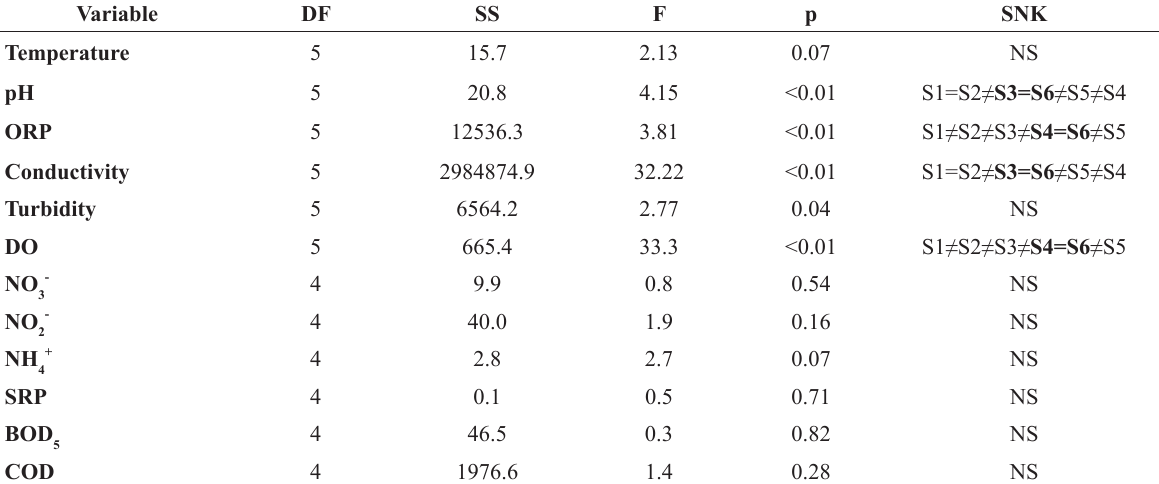
results of the analysis of Variance (anoVa) and a posteriori Student-neuman-Keuls (SnK) test for the physicochemical data recorded in Sites 1 to 6. orP: rEdoX potential; do: dissolved oxygen; no 3- : nitrates; no 2- : nitrites; nH 4+ : ammonia; SrP: Soluble reactive Phosphorous; dbo : biochemical oxygen demand; Cod: Chemical oxygen 5